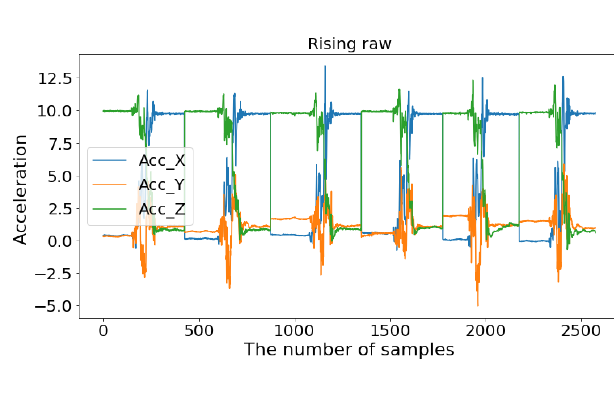
Fig 6. Six tests with the activity of rising.